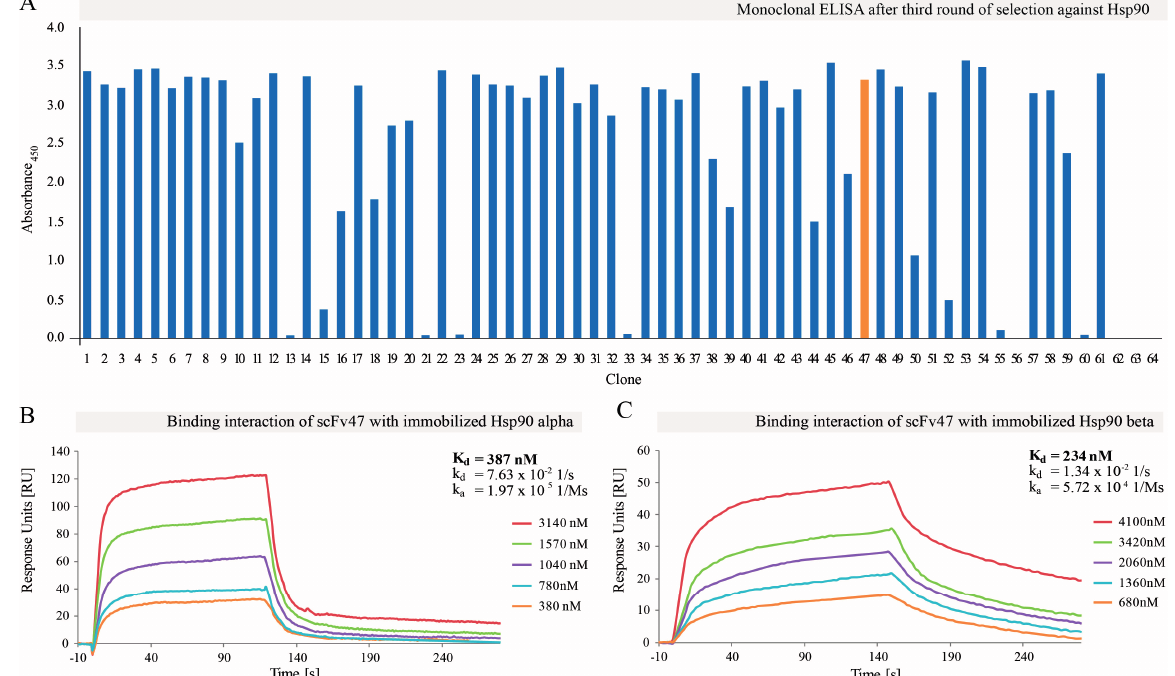
Figure 1. The results of phage display selection against Hsp90 α . ( A ) Monoclonal ELISA for 64 scFv clones selected after the third round of panning against Hsp90 α .